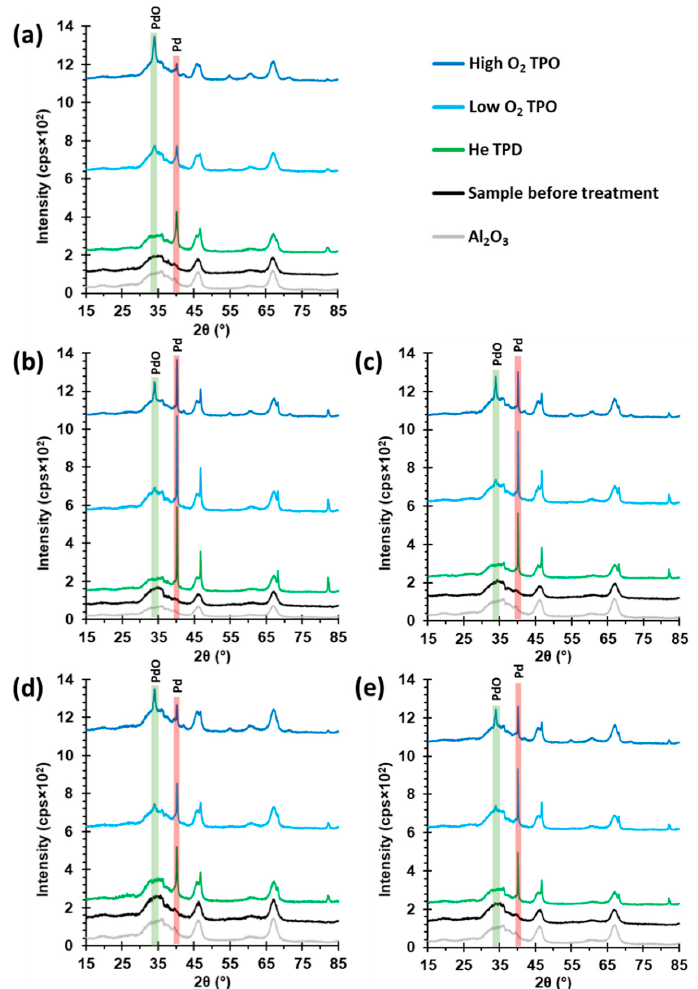
Figure 9. Powder X ‐ ray diffraction patterns of ( a ) PS/Al 2 O 3 , ( b ) PS + 0.25 AS/Al 2 O 3 , ( c ) 0.25 AS + PS /Al 2 O 3 , ( d ) PS + 1.0 AS/Al 2 O 3 , and ( e ) 1.0 AS + PS/Al 2 O 3 model catalysts after decomposition under varied oxygen concentrations. The characteristic main peaks of active PdO and inactive metallic Pd are highlighted in the